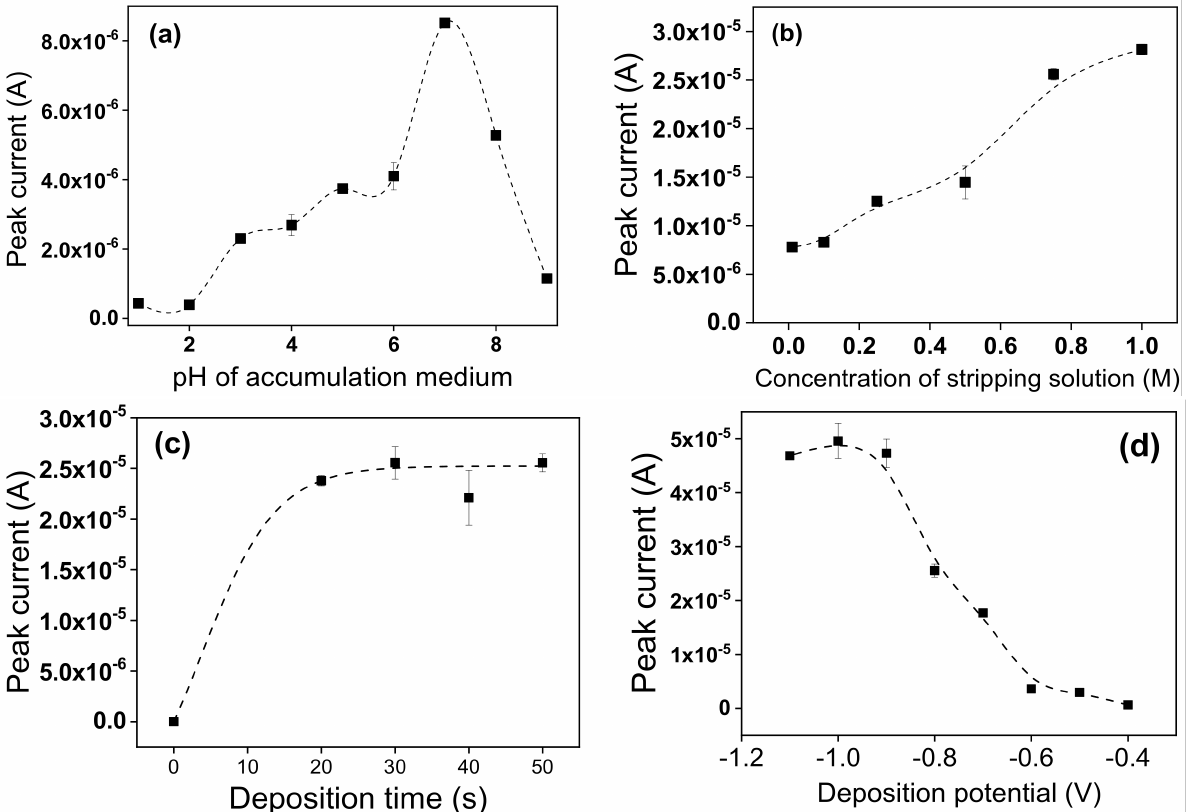
Figure 11. Influence of pH of the accumulation medium ( a ), the concentration of the stripping solution ( b ), the deposition time ( c ) and the deposition potential ( d ), on the stripping current response of TalcNH 2 /GCE (accumulation time of 1 min in 5 µ M Pb 2+ ). The experiments were conducted in